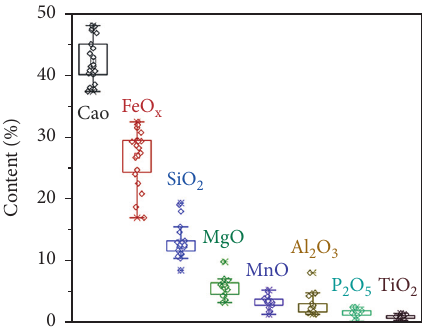
Figure 1: The chemical composition of BOF steel